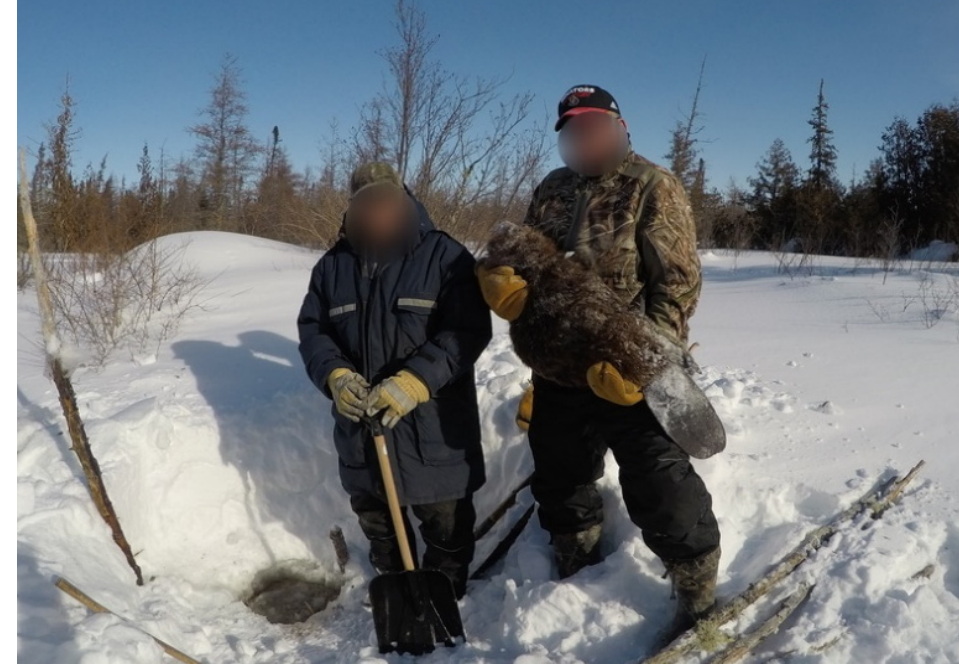
Figure 2. An Elder and on-the-land expert with a large beaver.